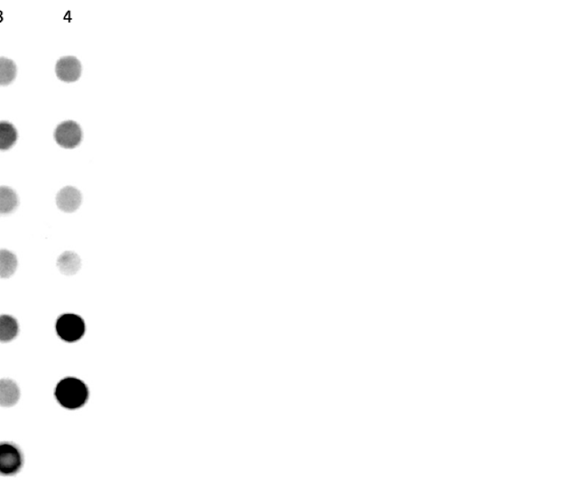
Figure 3 . Dot blot analysis of MUC8 in salivary stones from the excretory ducts of the submandib- ular glands. Each dot shows the positive detection of MUC8 in a salivary stone. The darker the dot, the higher the MUC8 concentration. Next to it in tabular form the sample designations, 1–24 denote the protein samples of the salivary stones, K1–K3 describe the saliva samples as positive controls. The intensity of the black staining indicates the different amounts of MUC8 contained. Individual samples (2, 5, 10, 20, 24) show a strong signal, whereas others react only very weakly (e.g., 1, 16). The positive controls are also stained black with varying intensity.